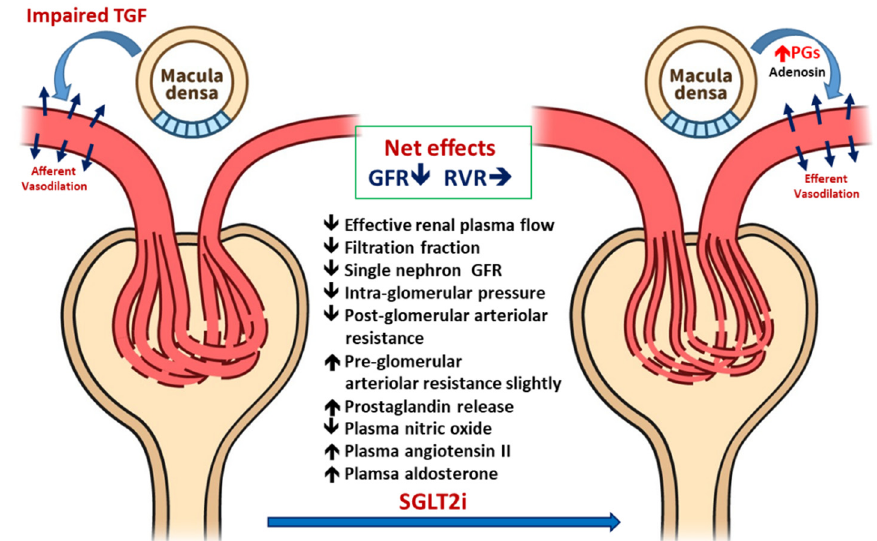
Figure 2. Hemodynamic responses to SGLT2i in patients with early stage type 2 diabetes mellitus (T2DM): in the early stage of T2DM, increased proximal tubular reabsorption will decrease the distal delivery resulting in impaired tubular glomerular feedback (TGF), which present with dilated glomerular a ff erent arteriolar and increased intraglomerular pressure. SGLT2i treatment will increase in dilated glomerular e ff erent arterioles. It also increased the adenosine level trivially, which